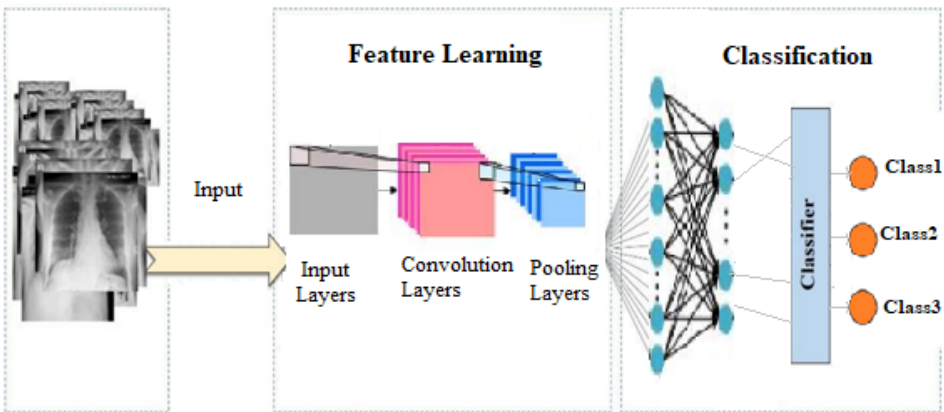
Figure 6. CNSN Flowchart on lung sample